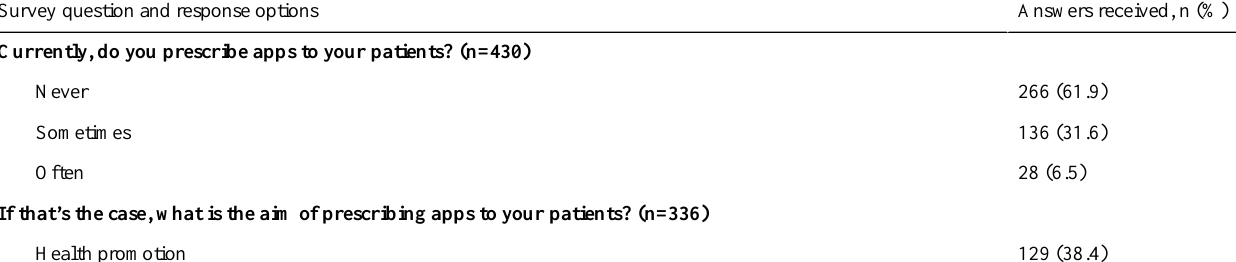
Answers received, n (%)Survey question and response